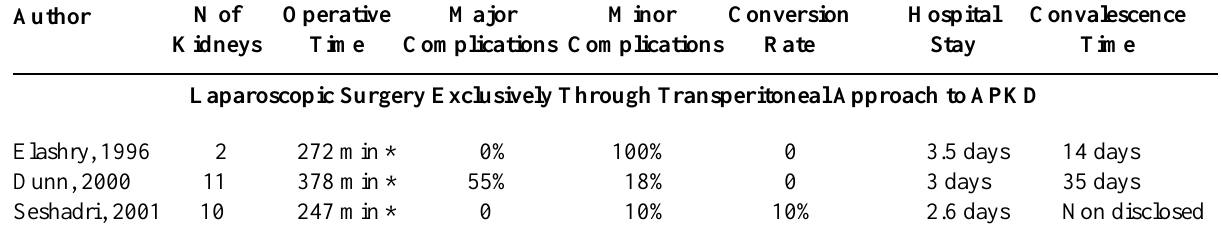
Table 2 – Laparoscopic treatment results in many series of nephrectomies for large renal specimens.